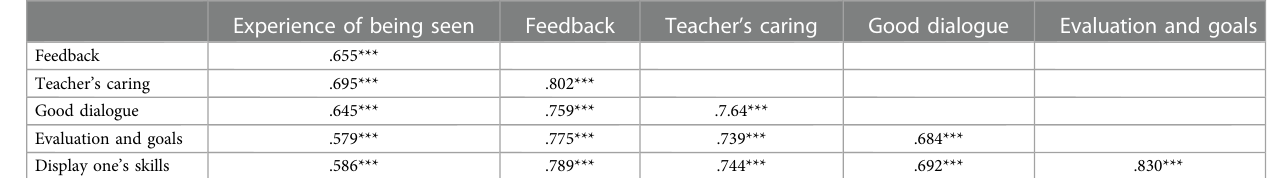
TABLE 4 Spearman ’ s correlation test between the fi ve factors and the experience of being